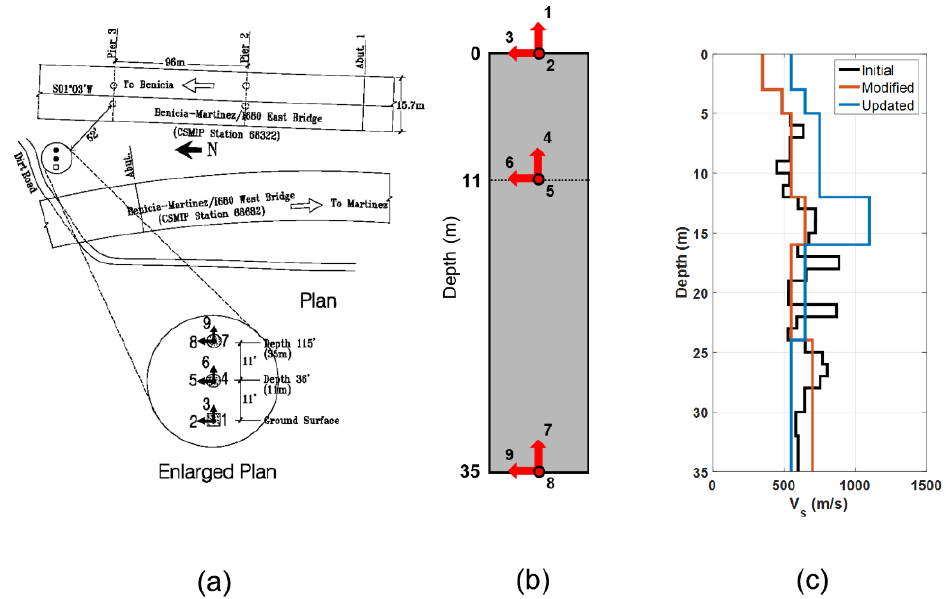
Figure 20. Benicia–Martinez geotechnical array. Instrumentation layout from CESMD ( a ), the location of sensors along the depth of the site ( b ), and shear wave velocity profile ( c ).